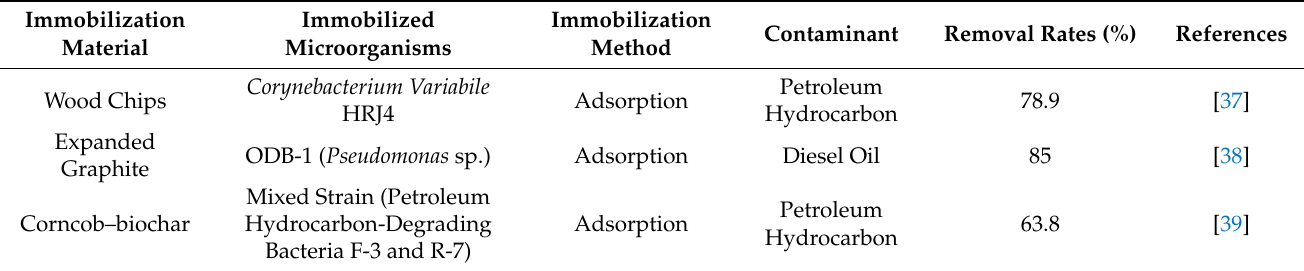
Table 2. The summary of the main microorganism immobilization materials used for oil removal in